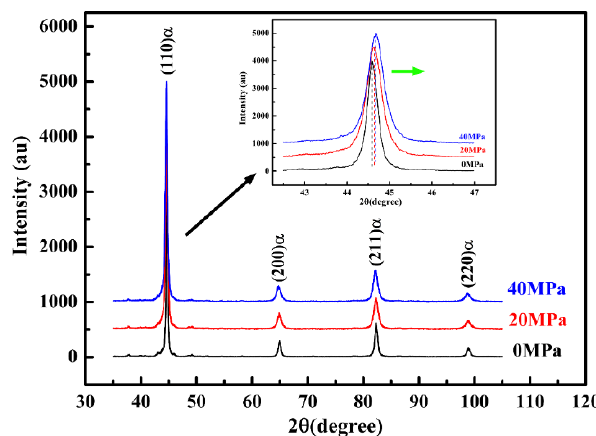
Figure 8. The X-ray diffraction (XRD) pattern of the specimens after being heated to 300 °C under different tensile stress.